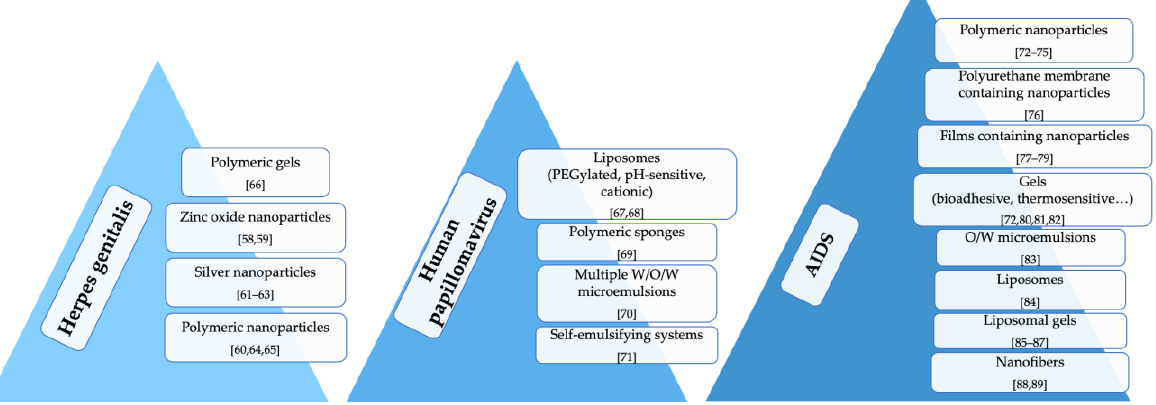
Figure 3. Innovative drug delivery systems for the local treatment of viral vaginal infections.